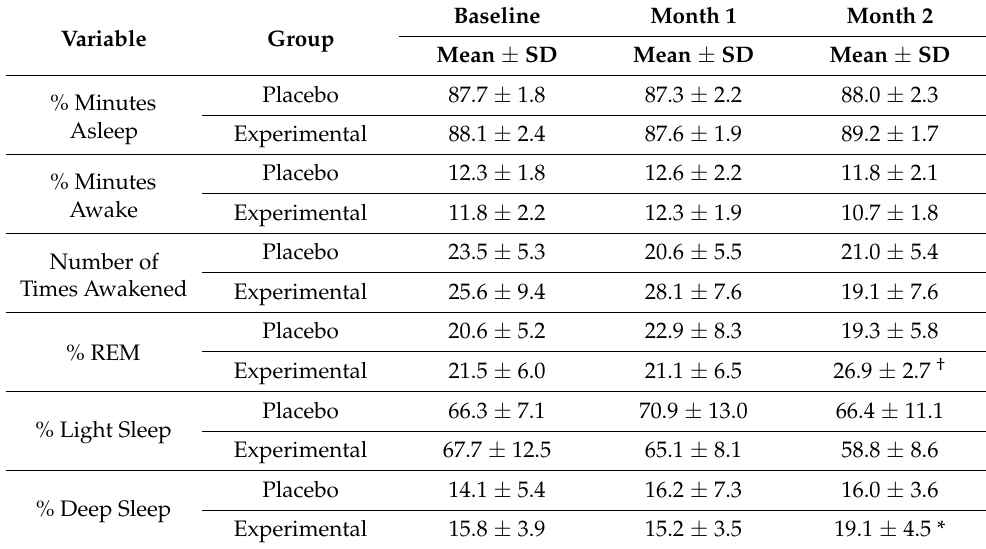
Table 10. Chart depicting Fitbit values in women population.